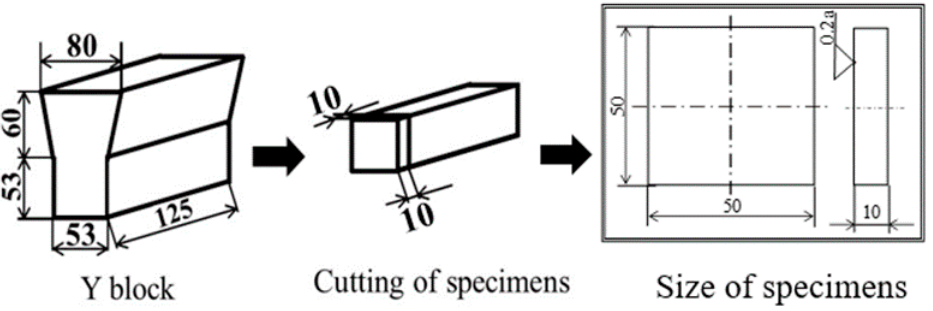
Figure 1. The dimension of Y-block and the finalized test piece.